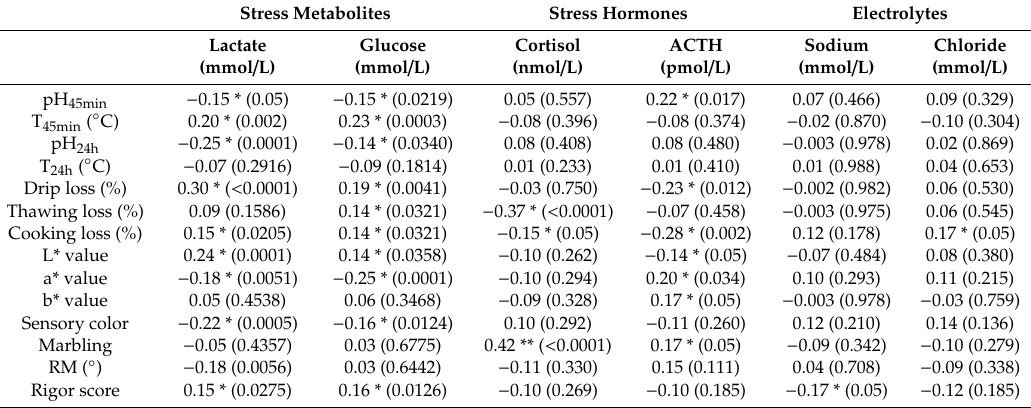
Table 3. Correlations (r) between stress metabolites, stress hormones, electrolytes, and meat quality traits in slaughter